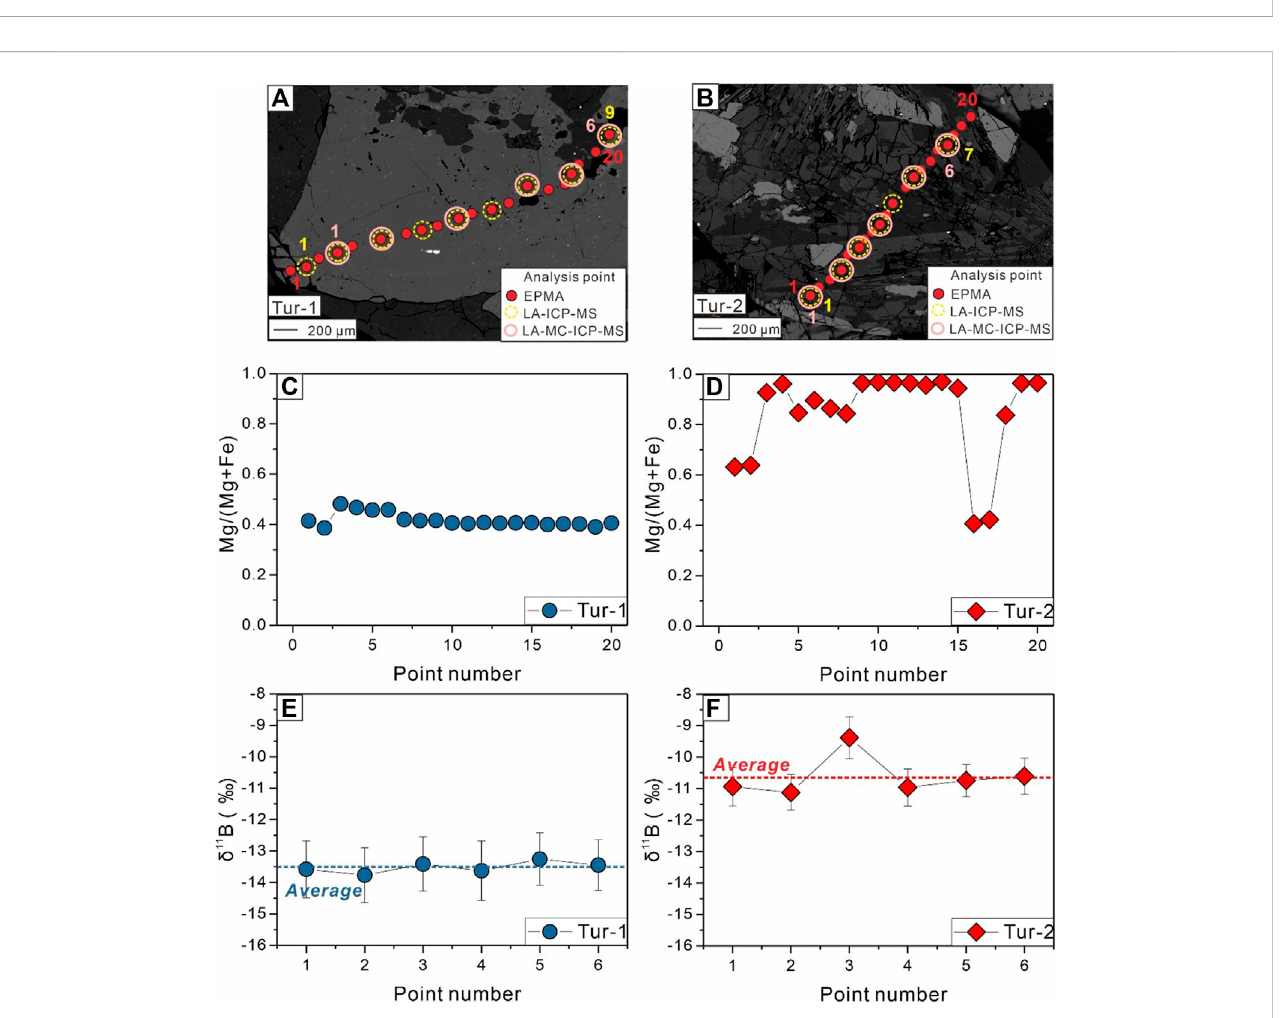
FIGURE 9 Composition changes in the tourmaline particle. (A – B) Analyzed point sites on the microscopic photograph; (C – D) change in the Mg/(Mg + Fe) ratio in the tourmaline particle; (E – F) change in the δ 11 B value in the tourmaline particle.